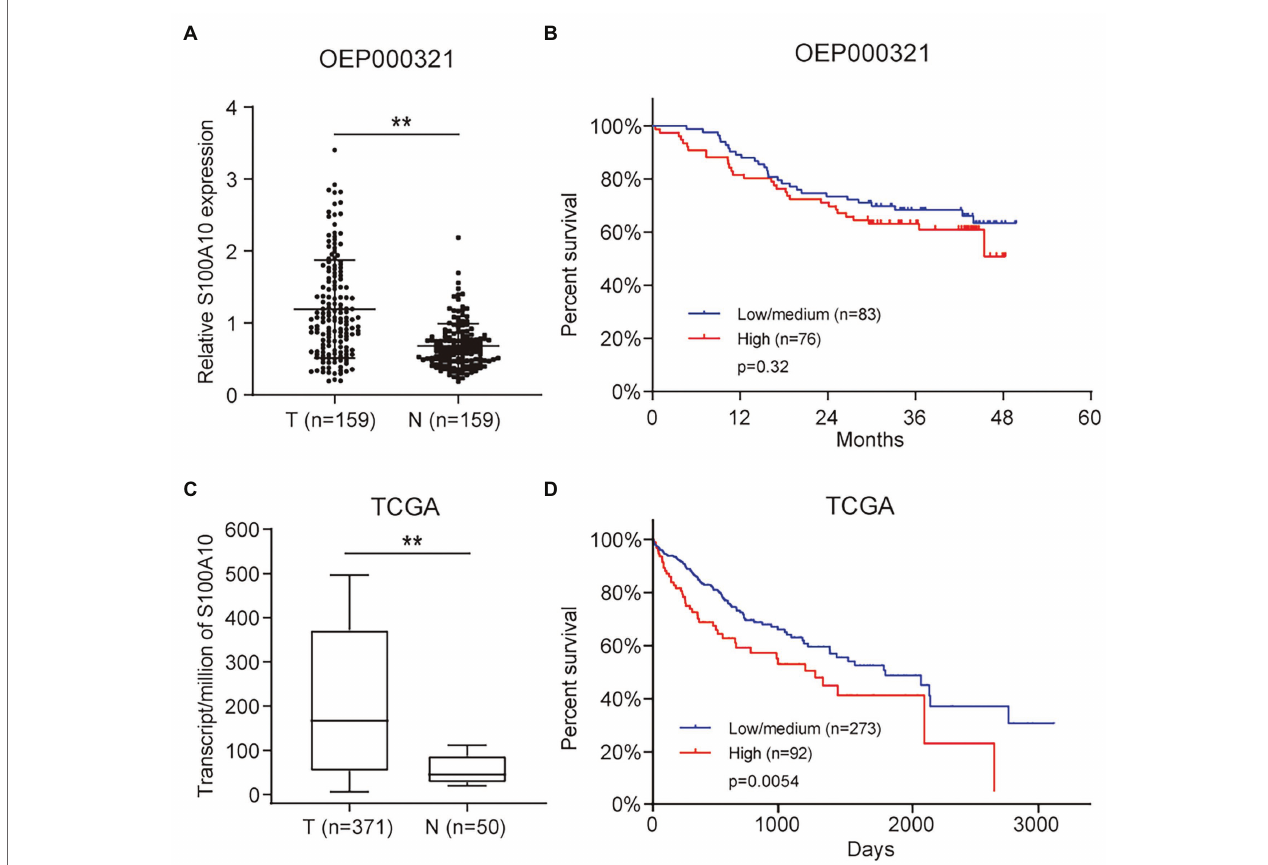
FIGURE 2 | S100 calcium binding protein A10 is upregulated in HCC and correlated with poor prognosis. (A) S100A10 expression in HCC tissues and adjacent normal tissues. (B) Correlations between S100A10 expression and the overall survival (OS) of HCC patients. (C) S100A10 expression based on the Cancer Genome Atlas (TCGA) cohort. (D) Correlations between S100A10 expression and the OS based on TCGA cohort. ** p <